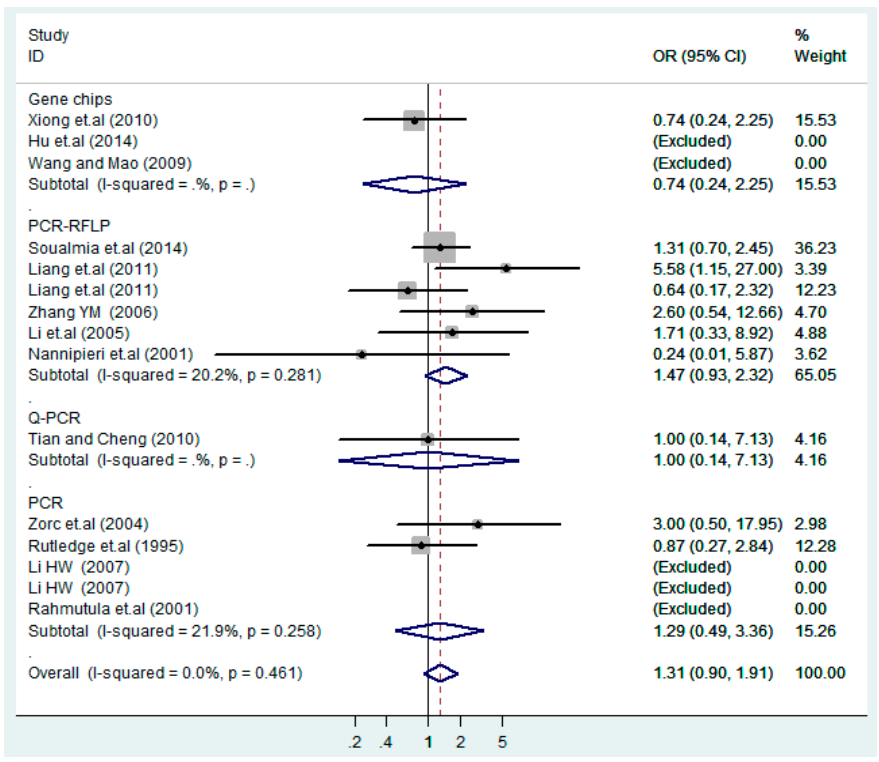
Figure 20. Subgroups of genotyping methods of T2238C co-dominant model-1 (TC vs. TT).